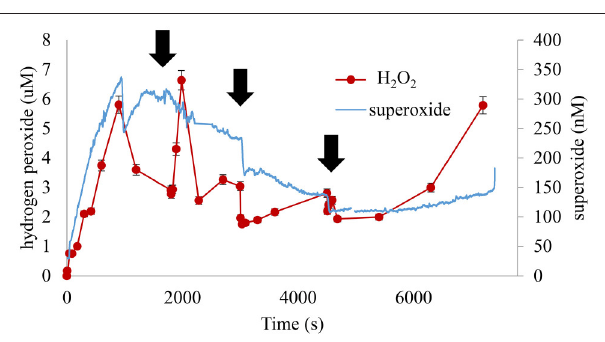
FIGURE 10 | Hydrogen sulfide addition decreased instantaneous ROS concentrations. The repeated addition of separate aliquots of hydrogen sulfide resulted in initial declines in ROS followed by slow recovery to pre-spike level. However, the system was robustly catalytic for ROS production overall and the variance between the highest and lowest ROS concentrations was generally less than a factor of 2 ( indicates time of sulfide addition, pH 8.25,